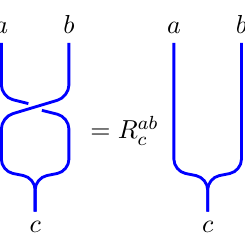
Figure 3 . The R -move untwists fusing anyon lines. Note that the anyon line b crosses over a . An undercrossing would correspond to using R − 1 instead of R